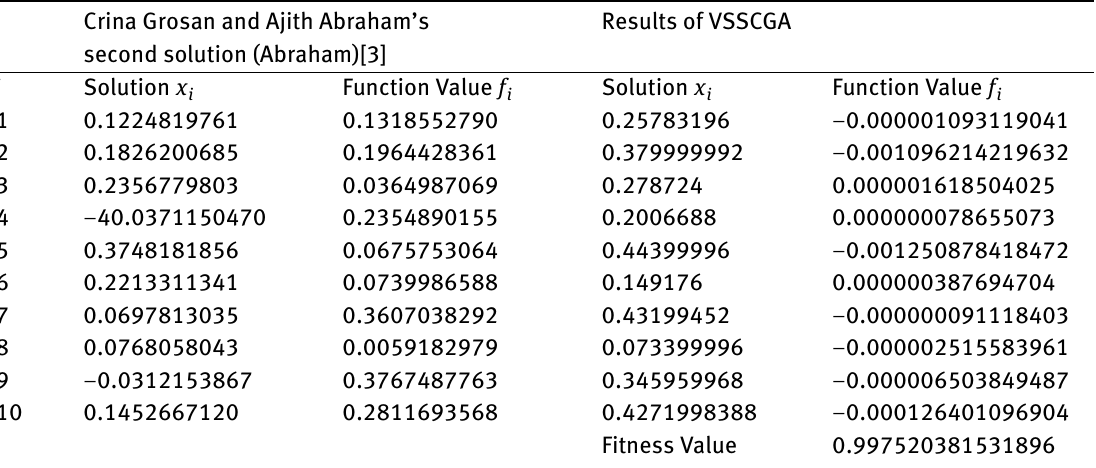
Table 34: Comparison of VSSCGA’s results with Crina Grosan and Ajith Abraham’s results for Interval arithmetic benchmark problem